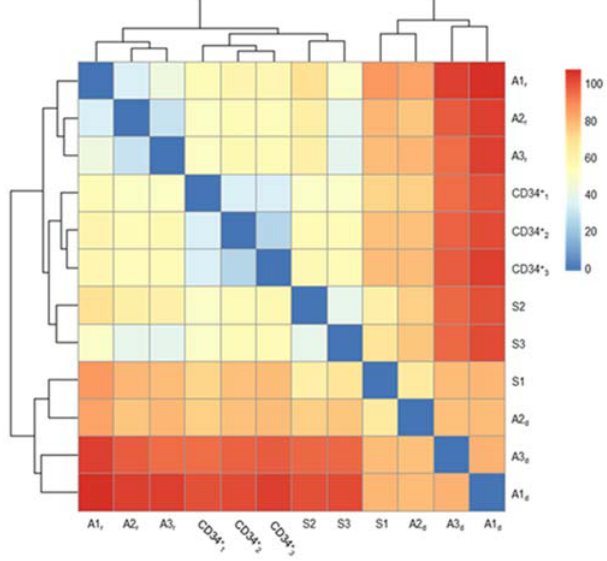
Figure 2. Unsupervised cluster heatmap of the Euclidean distances (0–100) among the twin samples (S1, S2, and S3), the three diagnosis–remission-paired samples (couples Ai d –Ai r , i = 1, 2, 3), and the CD34 i+ (i = 1, 2, 3) cells based on their DNA methylation values for 398,224 CpG loci. To verify that the “top” 5139 differentially methylated CpG sites corresponded to a signature characteristic of B-ALL, independent from the different proportion of blood cells in the samples, we compared the CpG site methylation levels among the leukemic samples (S1, A1 d , A2 d , and A3 d ) and non-leukemic samples (S2, S3, A1 r , A2 r , and A3 r ) and the non-leukemic CD19 + B cells and CD34 + cells isolated from the adult donors and cord blood samples, respectively. This set of non-leukemic reference cells represented mature B-cells (CD19 + ) and multipotent progenitor cells (CD34 + ). The “targeted” PCA (Figure 3) revealed a cluster of B-ALL-affected individuals distinct from the non-leukemic individuals and reference samples. PC2 separated the CD19 + cells from all the other samples. We imputed this result to the different ages between the CD19 + cell donors (adults) versus the infant samples.